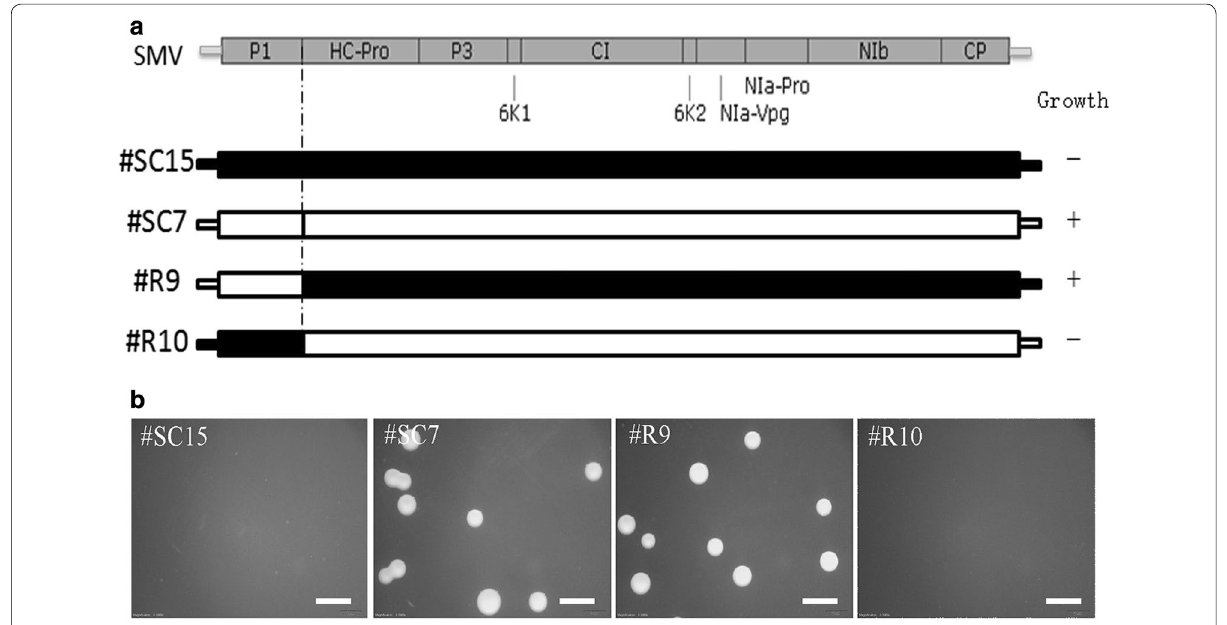
Fig. 3 Growth of Agrobacterium after transformation with the recombinant clones of #SC15 and #SC7. a The recombinant position of #SC15 and #SC7 and the growth of Agrobacterium after transformation. “ indicates those not. b Photographs of Agrobacterium growth after the transformation of each recombinant clone; scale bars